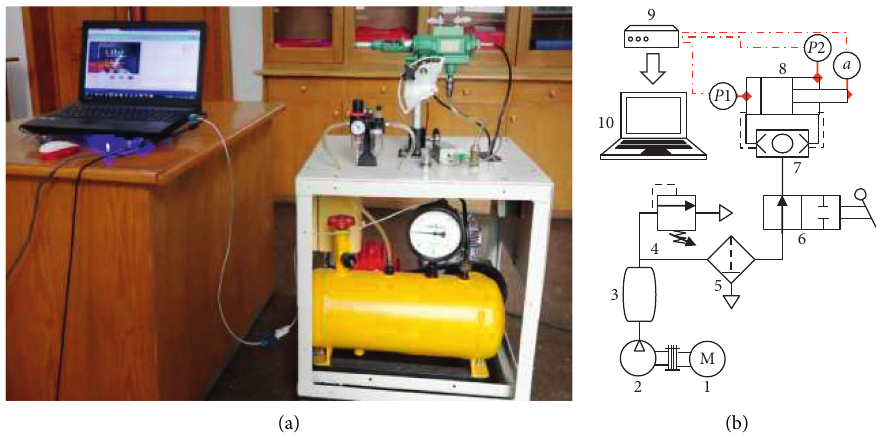
Figure 9: The experimental setup and its layout for the small pneumatic hammer manufactured by Kim Chaek University of Technology.1. Motor; 2. Compressor; 3. Air tank; 4. Safety valve; 5. Filter; 6. Switching valve; 7. Control valve; 8. Impact cylinder; 9. Multichannel waveform recorder; 10. PC; P 1 —pressure sensor at the rear chamber; P 2 —pressure sensor at the front chamber; a—piston acceleration sensor. (a) Experimental test setup. (b) The experimental setup